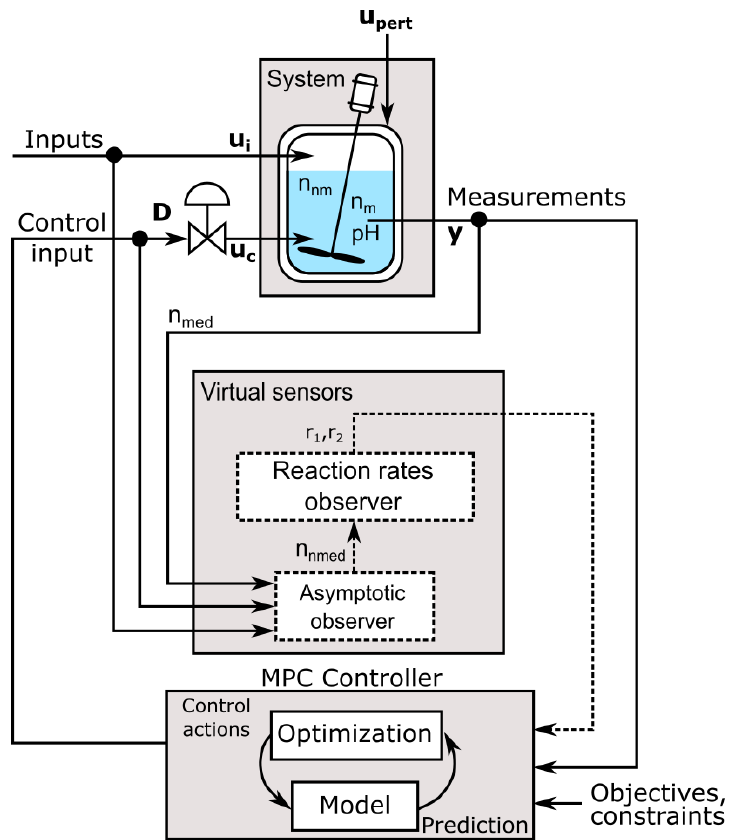
Figure 2. Model Predictive Control structure for the anaerobic